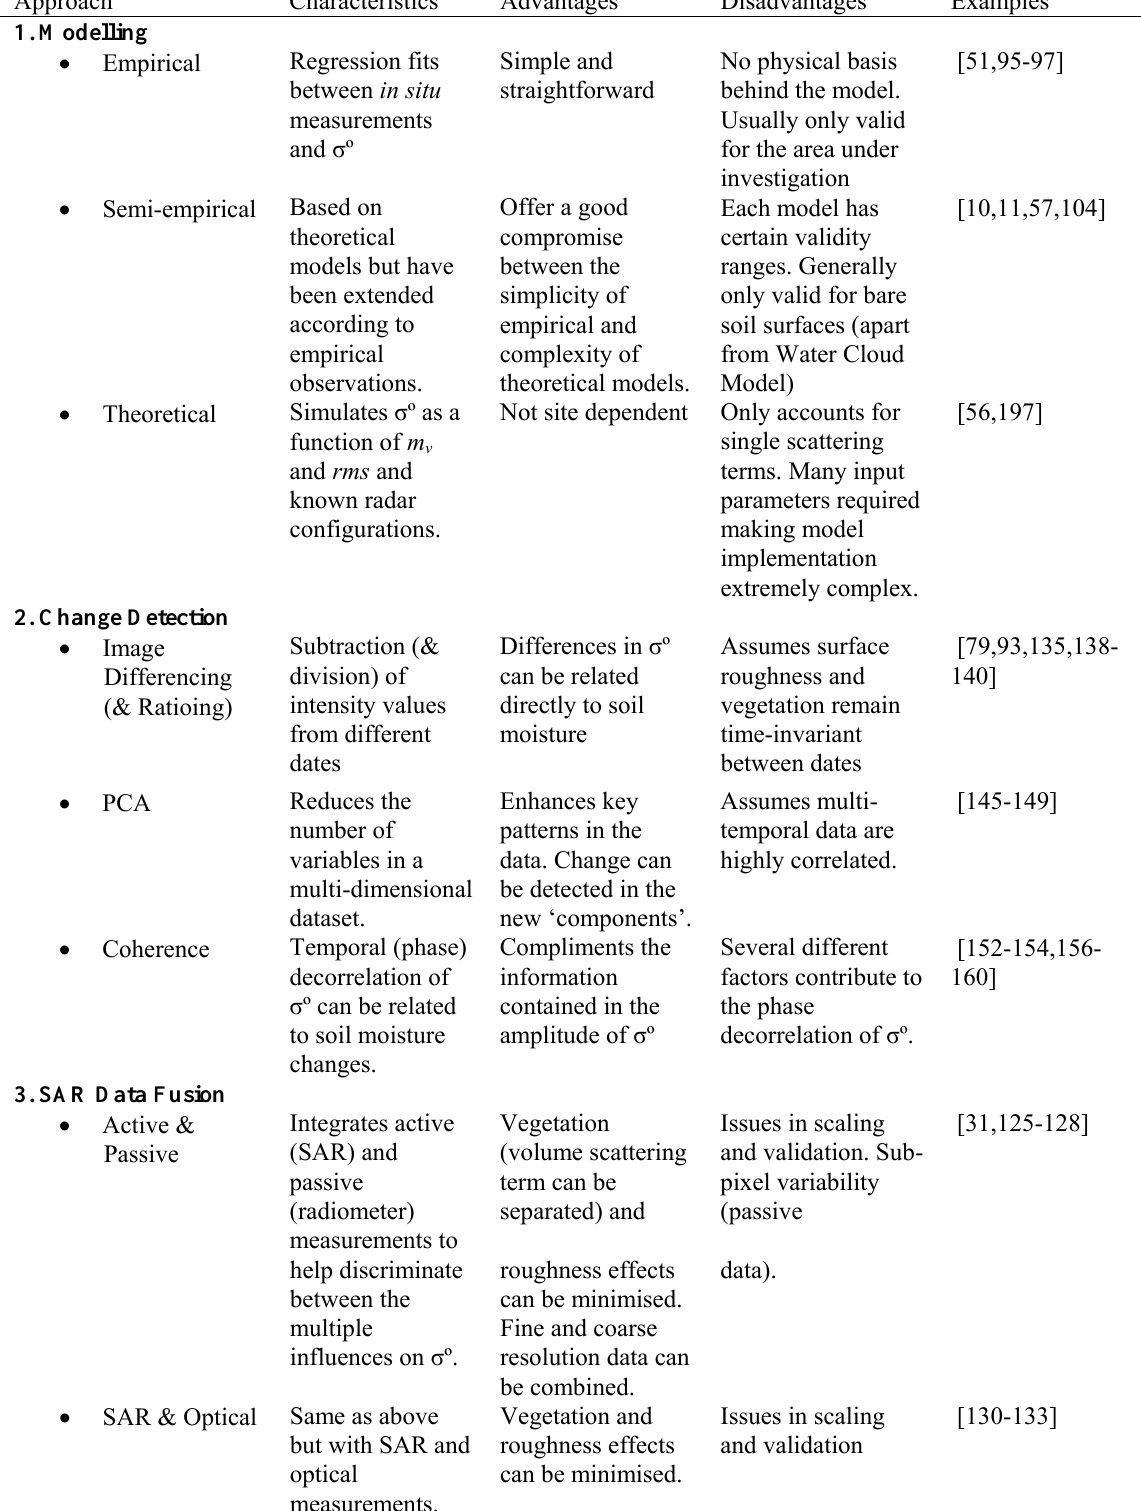
Table 2. Summary of soil moisture retrieval techniques from SAR data. Approach Characteristics Advantages Disadvantages